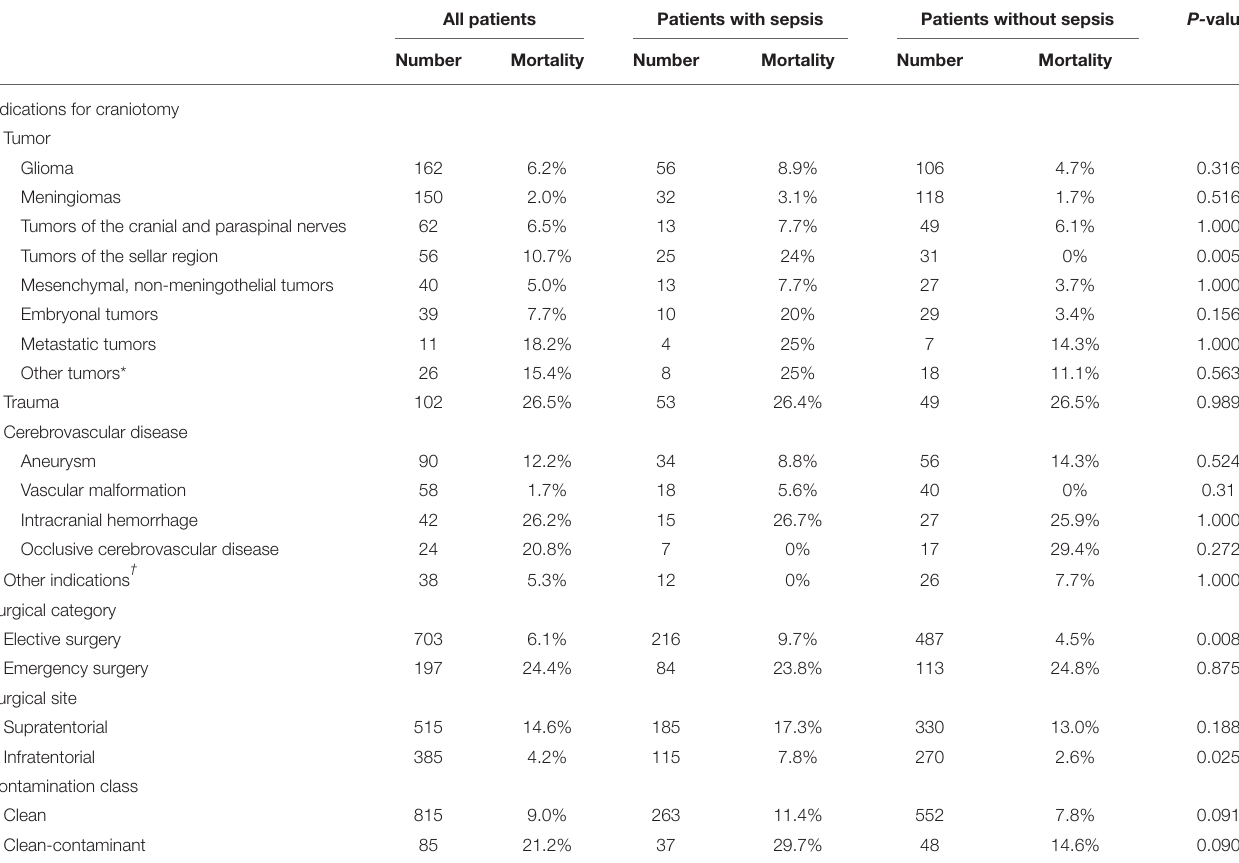
TABLE 5 | Mortality rates of patients with different intracranial diseases, surgical categories, surgical sites, and surgical wound